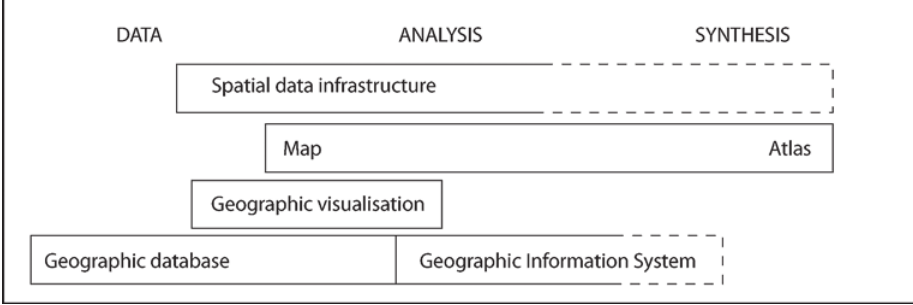
Fig. 4. Levels of integration of geographic